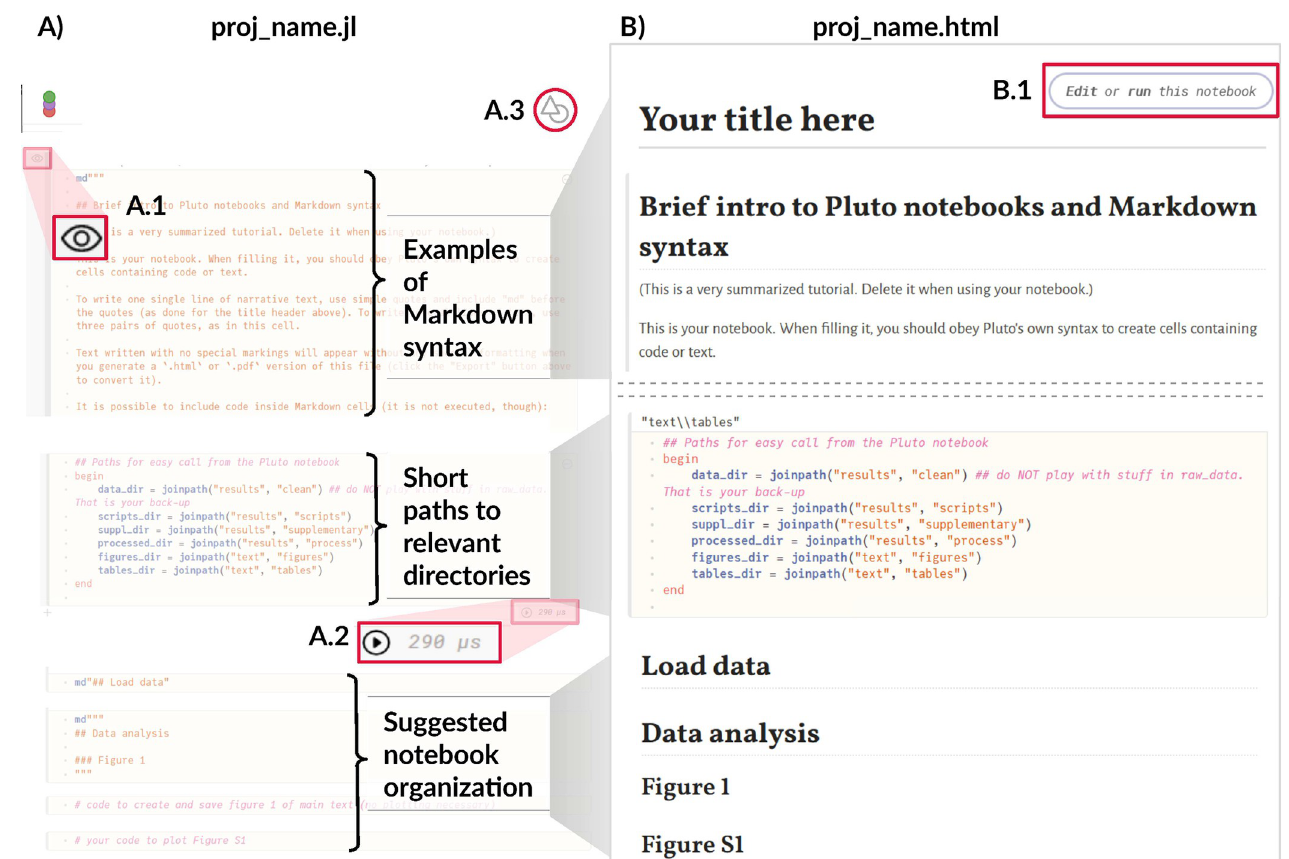
Fig 4. Comparison between the Pluto notebook file available for editing (A) and the rendered html version (B). The function in set_kit.jl creates a.jl file (A) with a brief tutorial on the Markdown syntax, paths to the most relevant folders, and suggestions of use. The Pluto notebook offers the following features: Cells of code can be hidden by clicking the “Show/hide code” button (A.1), the time for running the code is shown alongside the “Run” button (A.2), and the file type to be exported (.jl,.html, or.pdf) can be chosen by clicking the “Export” button (A.3)—no detailed formatting is possible, however. In the html version (B), a button (B.1) allows the reader to edit and run the code on Binder, a free cloud server for scientific notebooks. The video accompanying this tutorial details how the document works (available in https://github.com/FellowsFreiesWissen/computational_notebooks).